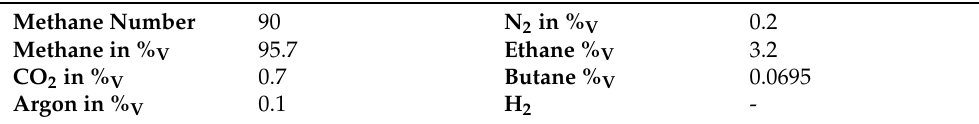
Table 3. Properties of natural gas.